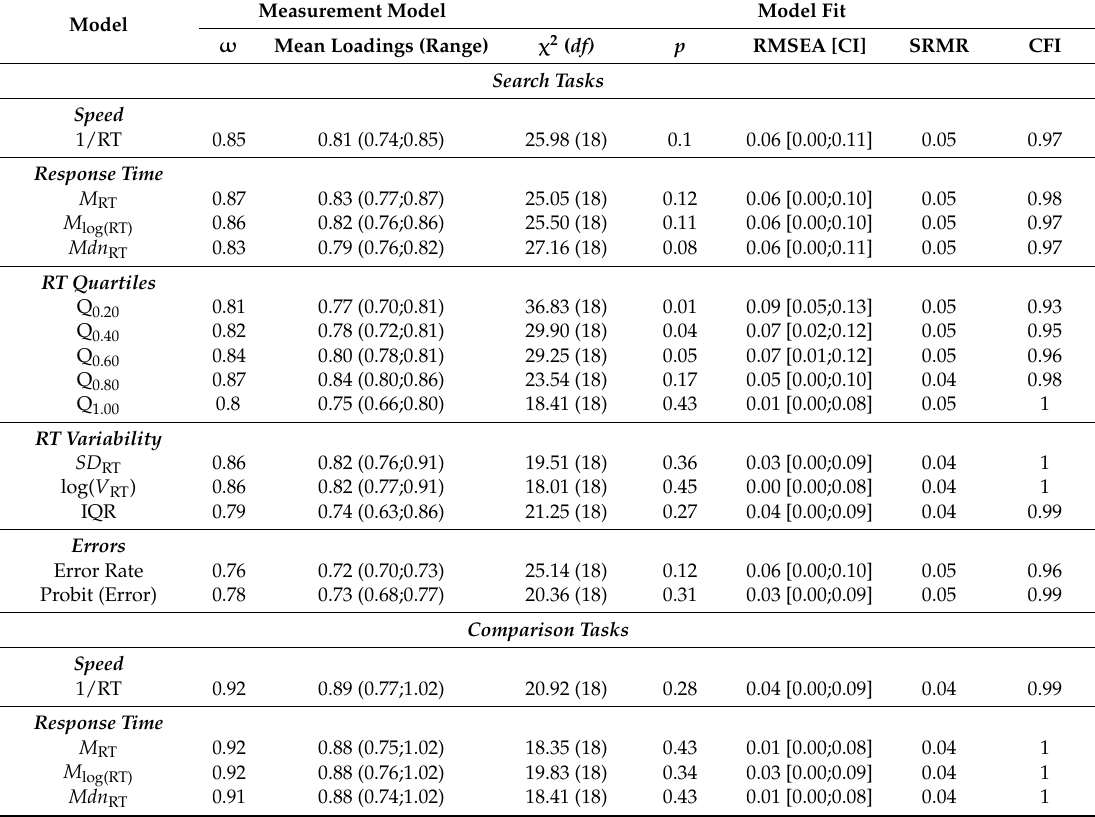
Table A2. Measurement models and model fit of mental speed task-specific factor